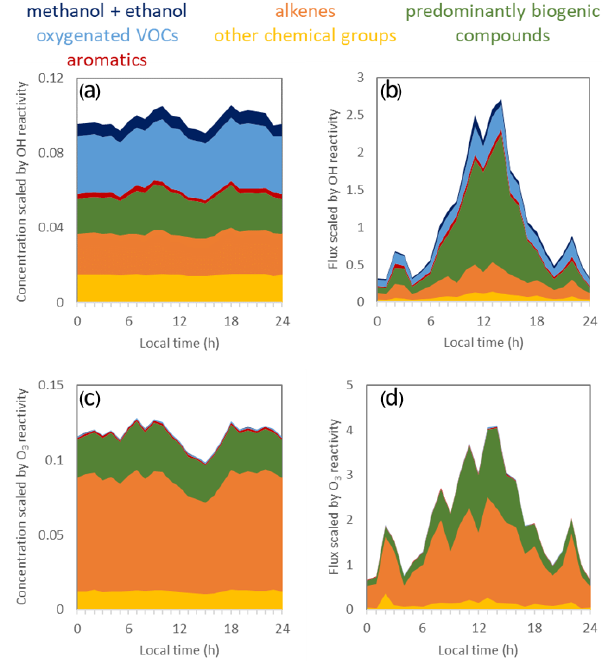
Figure 10. Total observed VOC concentration and flux measured during the summer field campaign scaled using by OH (a, b) and O 3 (c, d) reactivity relative to